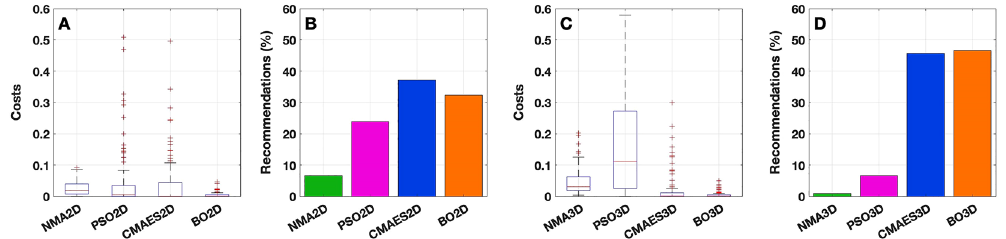
Figure 11. Cost function values and recommendations pertaining to the optimization algorithms for the 2Dim ( A , B ) and 3Dim ( C , D ) cases. ( A , C ) Boxplots illustrate the distribution of costs (normalized by the respective maxima, i.e. one value over all algorithms in the given parameter space). The considered methods are depicted on the horizontal axes together with the values of (cid:31) cost on the vertical axes. A few outliers for PSO (> 0.6 in 3Dim) and CMAES (> 0.6 in 2Dim) are not included in the plots. ( B , D ) Histograms show the relative number of recommendations obtained by a given optimization algorithm (calculated as in Fig. 6). The methods are